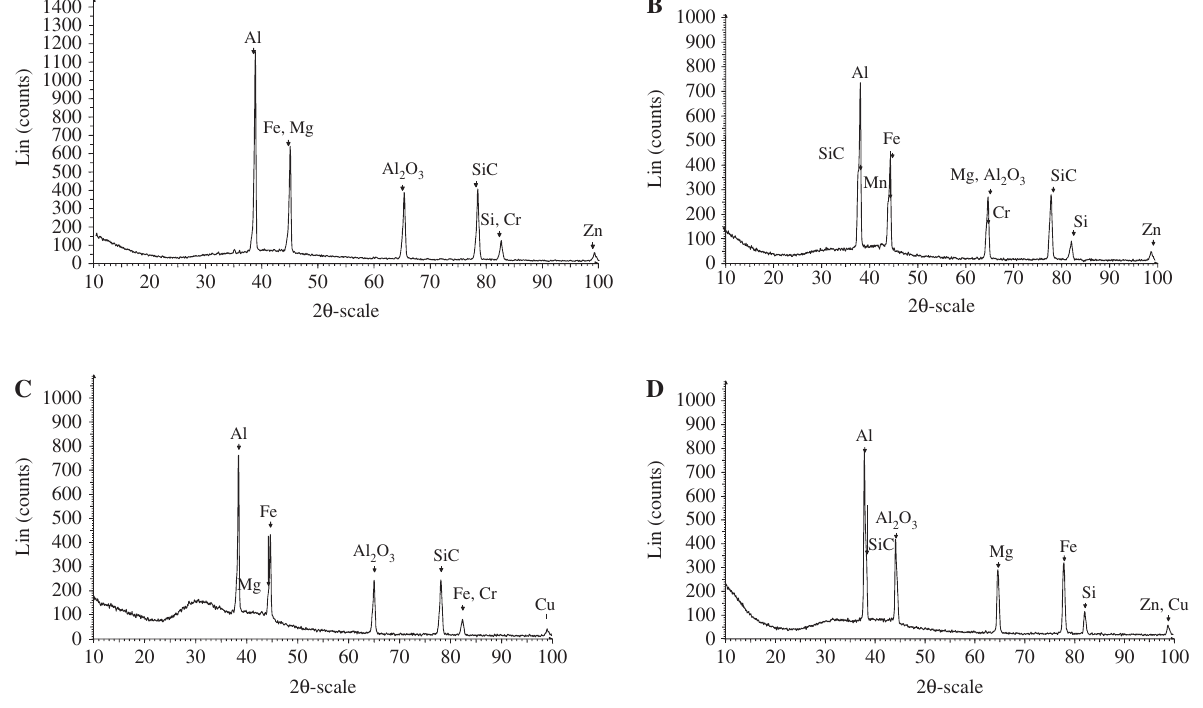
Figure 4: X-ray diffractometry curves of Al 7075/SiC/Al